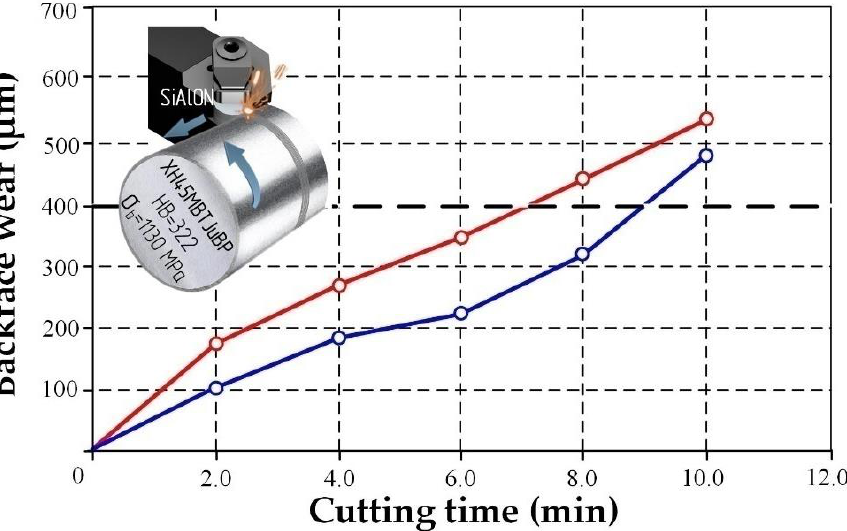
Figure 10. Dependences of the average backface wear value of SiAlON ceramic inserts after diamond grinding (red curve) and diamond grinding, lapping, and polishing (blue curve) on the cutting time when turning XH45MBTJuBP heat-resistant nickel alloy (V = 300 m/min, S = 0.2 mm/rev, t = 0.8